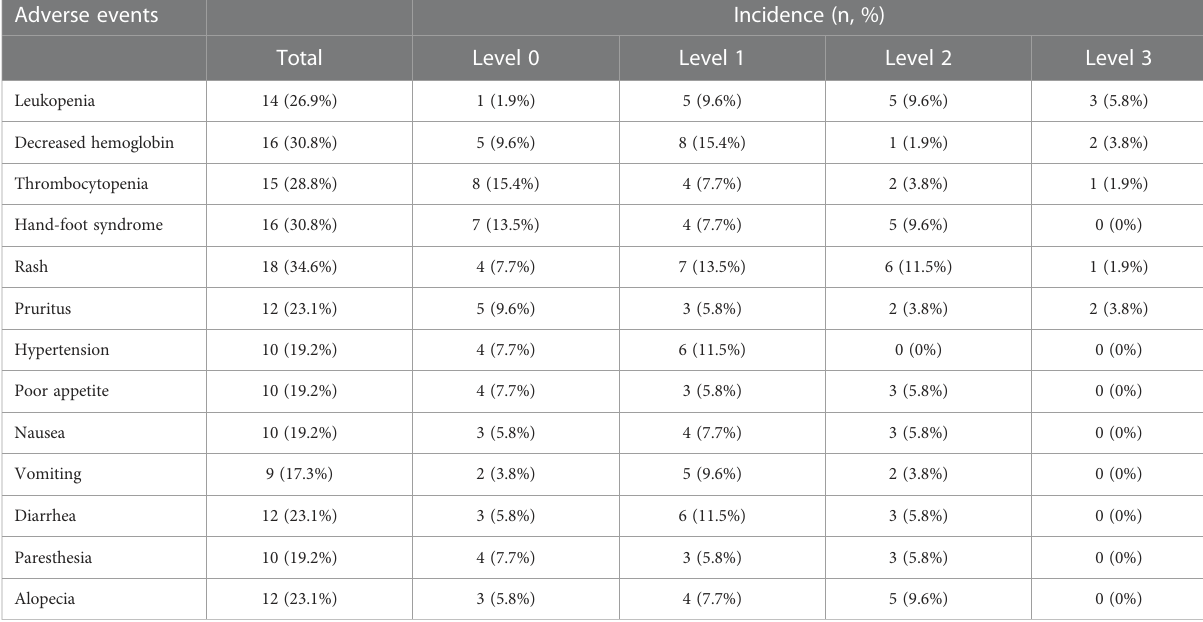
TABLE 3 Adverse events in the TS